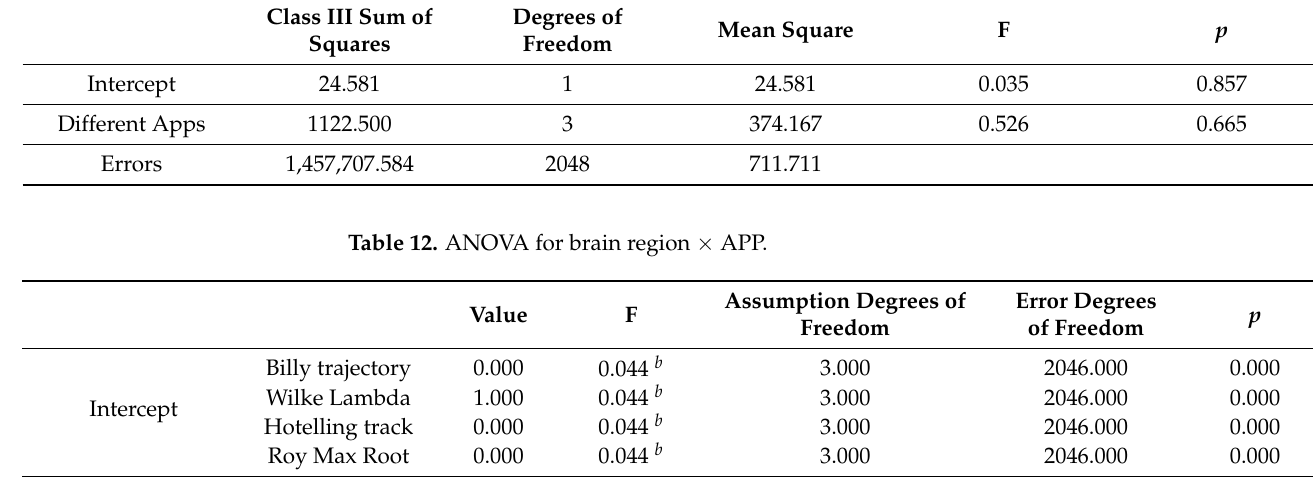
Table 11. ANOVA for different applications.